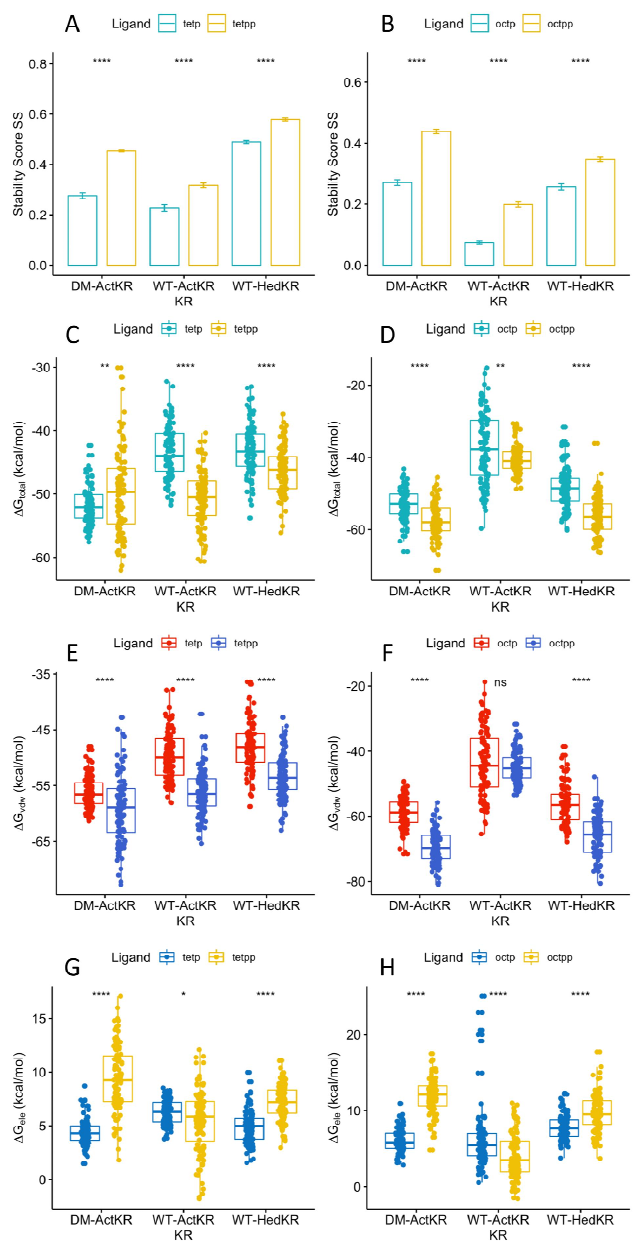
Figure 6. Stability score SS and MMPBSA comparison of DM- Act KR, WT- Act KR and WT- Hed KR bound with tetraketides and octaketides. All systems in ( A , B ) showed identical pattern that ligands with phospho-pantetheine moiety had significantly higher SS than those with pantetheine moiety, regardless of being octaketide or tetraketide. ( C ) Total binding free energy ∆ G total of tetraketides binding. ( D ) Total binding free energy ∆ G total of octaketides binding. ( E ) Non-electrostatic binding free energy ∆ G vdw of tetraketides binding. ( F ) Non-electrostatic binding free energy ∆ G vdw of octaketides binding. ( G ) Electrostatic binding free energy ∆ G ele of tetraketides binding. ( H ) Electrostatic binding free energy ∆ G ele of octaketides binding. Significance levels: ns, p > 0.05; *, p <= 0.05; **, p <= 0.01; ***, p <= 0.001; ****, p <= 0.0001.